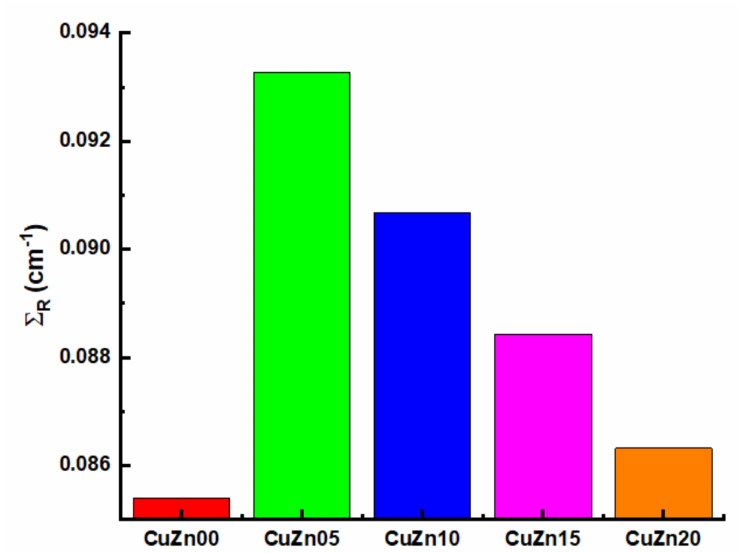
Figure 15. Fast neutron removal cross sections ( Σ R ) values for the selected